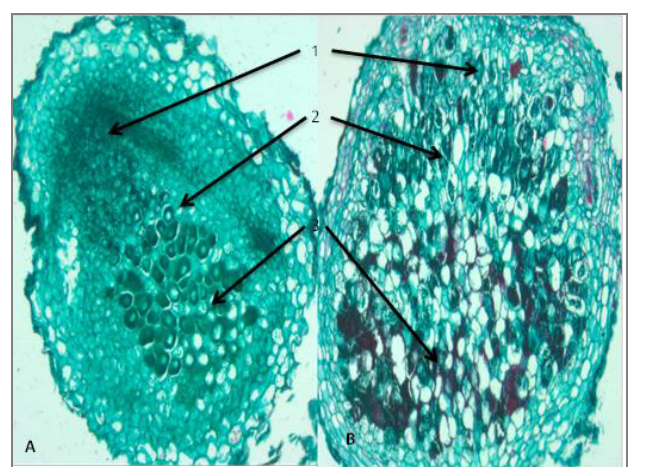
Figure 3 . Nodule examination by light microscope. (3A) transfer section of wild type nodule, (3B ) transfer section of blkn nodule. (1) bacterial infection zone; (2) nitrogen-fixing zone; (3) senescent zone. blkn transfer section is completely different from this of R108 in both number and size of cells in bacterial infection zone and nitrogen fixation zone.